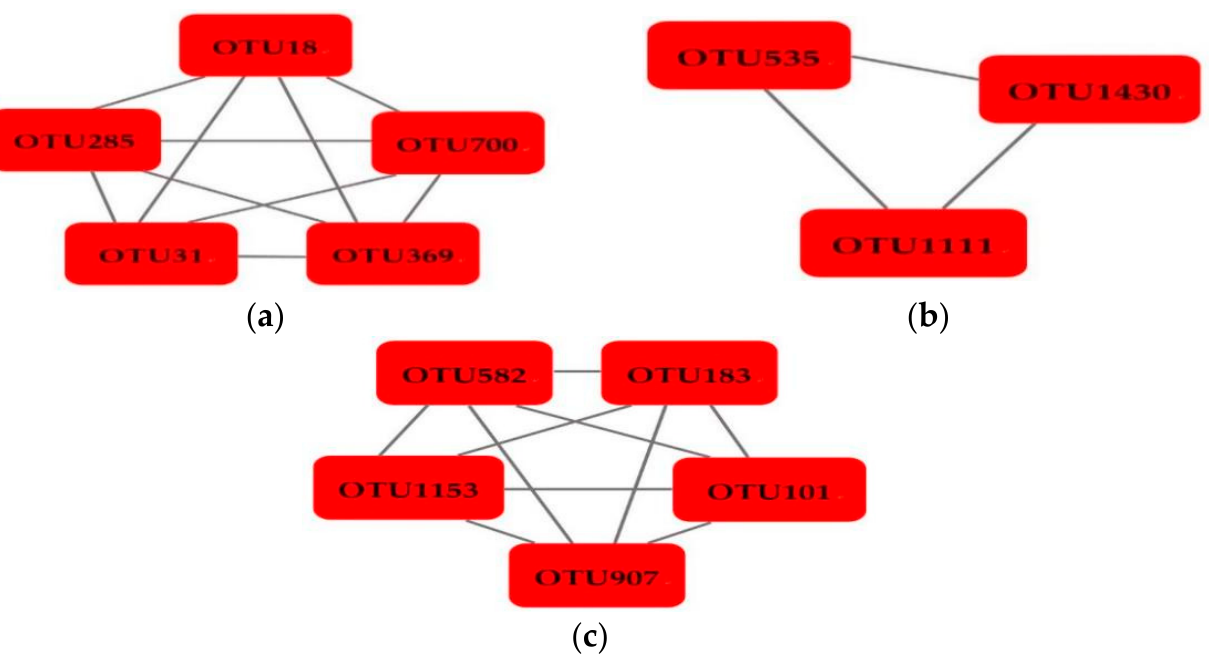
Figure 5. Network diagram of the core gut microbiome of the all samples group. ( a ) represents module1. ( b ) represents module2. ( c ) represents module3.